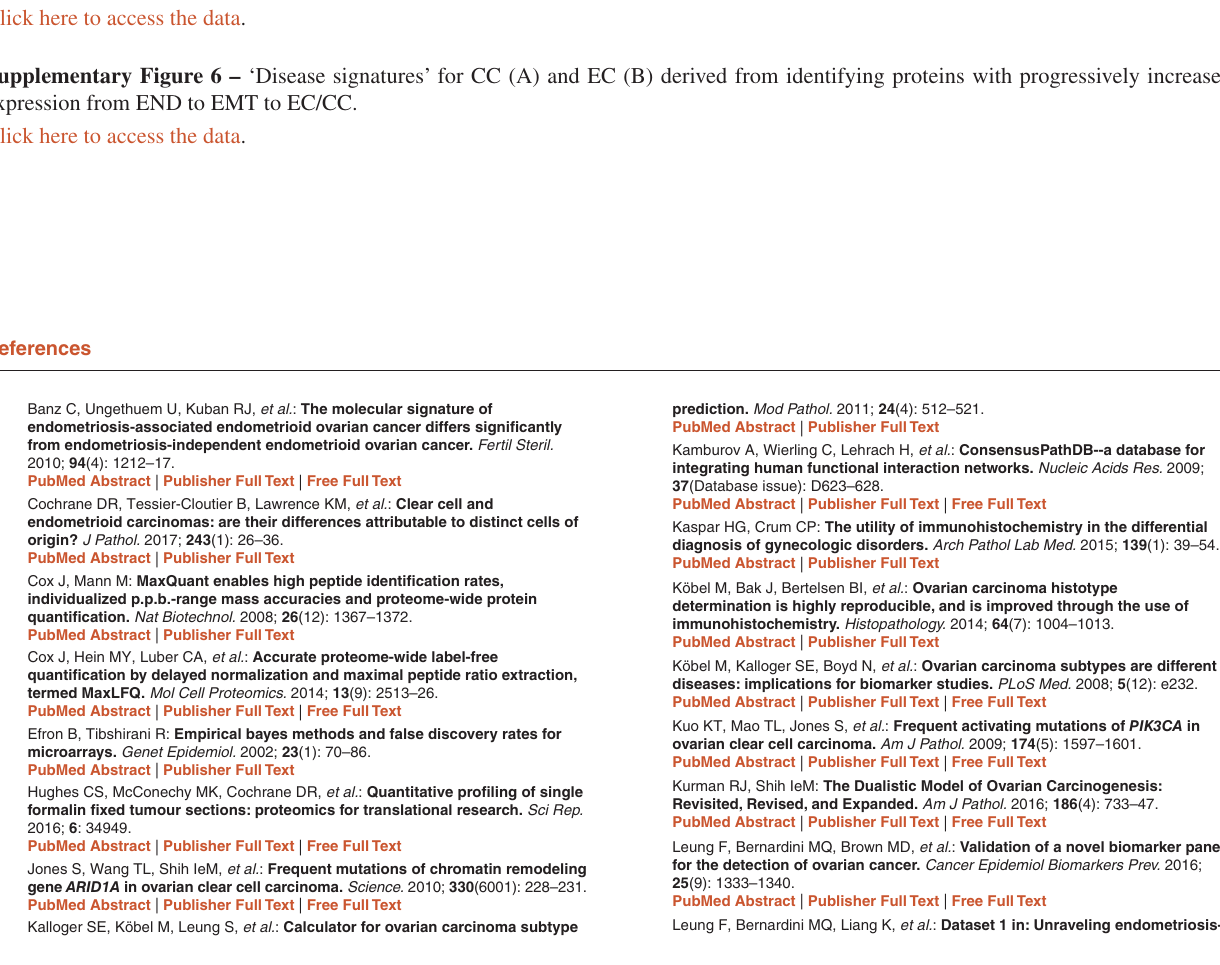
Supplementary Table 3 – Differential proteins identified with significant increased expression from END to EMT to EC. Click here to access the data. Supplementary Table 4 – Differential proteins identified with significant increased expression from END to EMT to CC. Click here to access the data. Supplementary Figure 1 – Summary of number of proteins identified overall and within the patient cohorts. The error bars represent standard deviation of protein identified with at least two unique peptides within each patient cohort. Click here to access the data. Supplementary Figure 2 – Identified proteins categorized according to the number of peptide hits associated with each protein identification. An identified protein was defined as any protein with a non-zero normalized LFQ value in at least one patient sample. Click here to access the data. Supplementary Figure 3 – Conservation of levels of ribosomal biogenesis and assembly proteins across the 21 biological replicates. The protein intensity levels are derived from the label-free quantification intensities generated from MaxQuant. Click here to access the data. Supplementary Figure 4 – Clustering analysis of concordant proteins across the cancer and control cohorts. Click here to access the data. Supplementary Figure 5 – Expression levels of ARID1A-related proteins (A) and PIK3CA/PTEN-related proteins (B) across the cancer and control cohorts. Click here to access the data. Supplementary Figure 6 – ‘Disease signatures’ for CC (A) and EC (B) derived from identifying proteins with progressively increased expression from END to EMT to